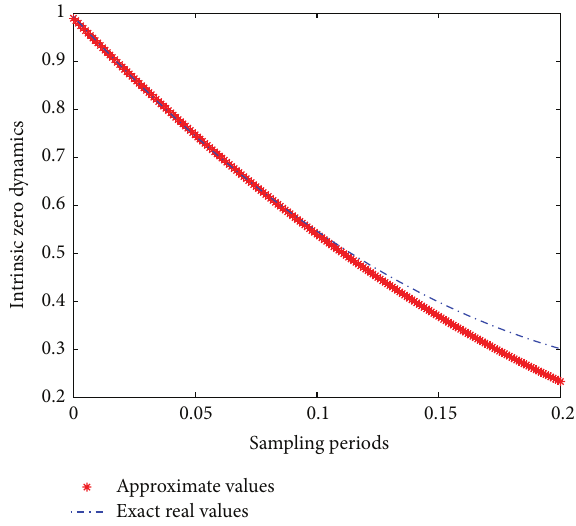
Figure 2: Intrinsic zero dynamics of the discrete-time model with time delay and relative degree